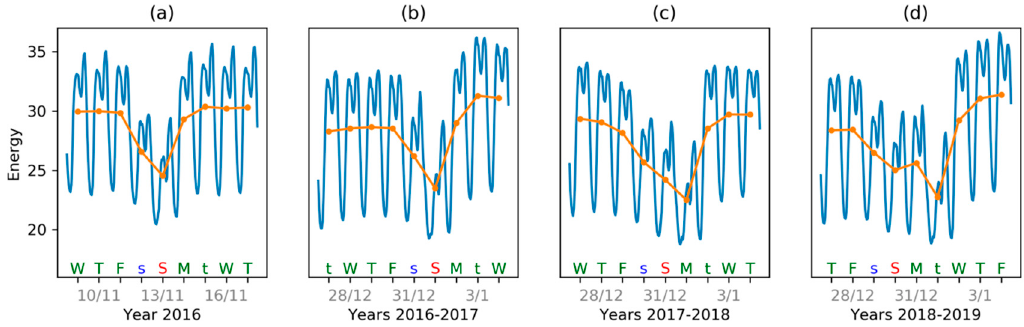
Figure 24. Weekly evolution: ( a ) Normal week; ( b ) 2017 New Year’s week (about normal); ( c ) 2018 New Year’s week (identified as abnormal by IMF 6); ( d ) 2017 New Year’s week (identified as abnormal by IMF 7).